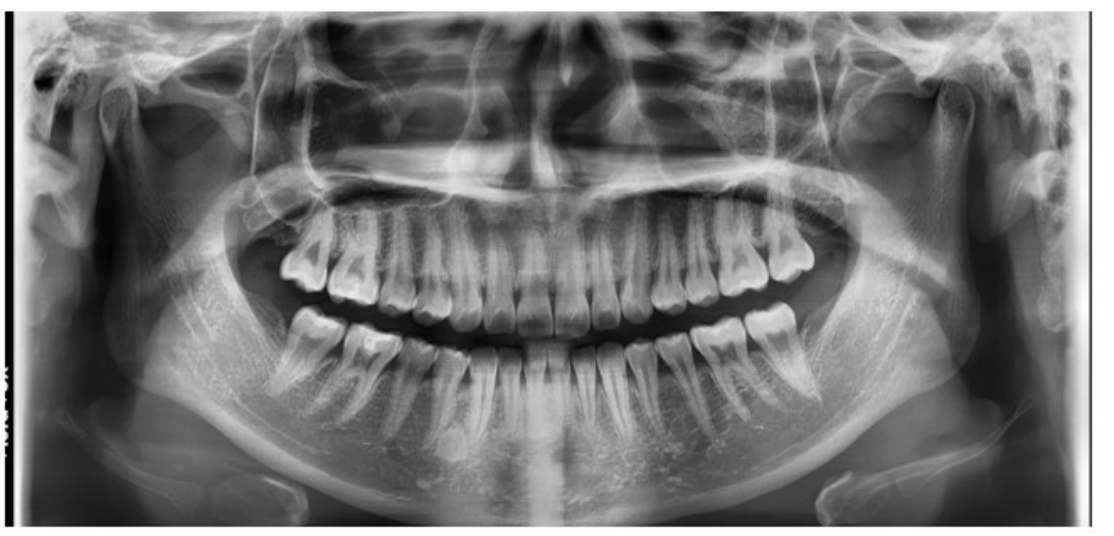
Fig. 6b - Panoramic radiograph - no radiological signs of radix entomolaris and C - shaped configura�on of root canals in the mandibular